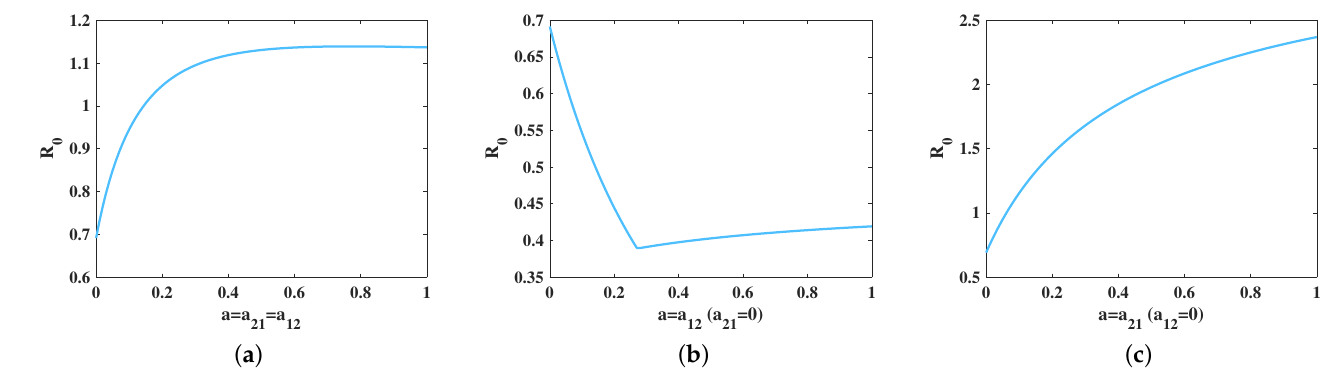
Figure 5. ( a ) R 0 versus a (The transportation rate between the two places is the same). ( b ) R 0 in terms of a (There is only transportation from Ulanhot to Jalaid banner). ( c ) R 0 in terms of a (There is only transportation from Jalaid banner to